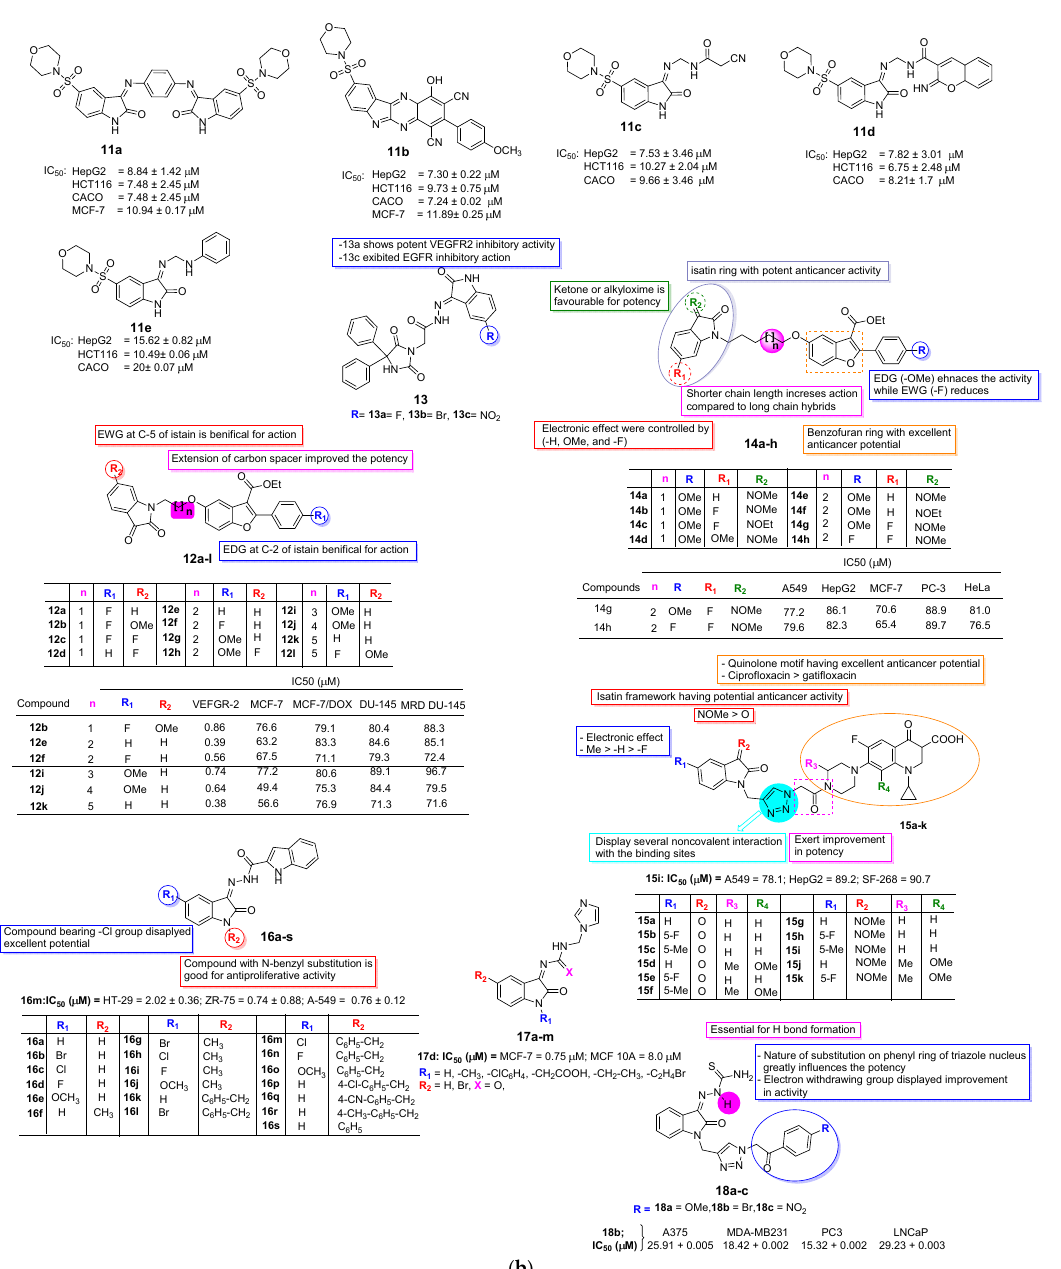
Figure 3. ( a ) SAR features of isatin derivatives exhibiting anticancer action. ( b ) Isatin derivatives exhibiting anticancer action and their SAR features.